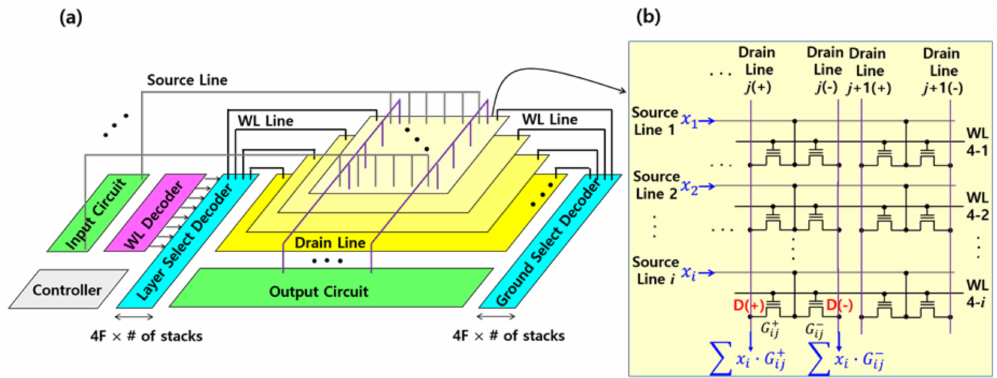
Figure 3. Schematic of the proposed 3-D synapse array architecture. ( a ) Metal interconnection of a full-chip architecture; ( b ) Each synapse layer configuration to implement artificial neural network.